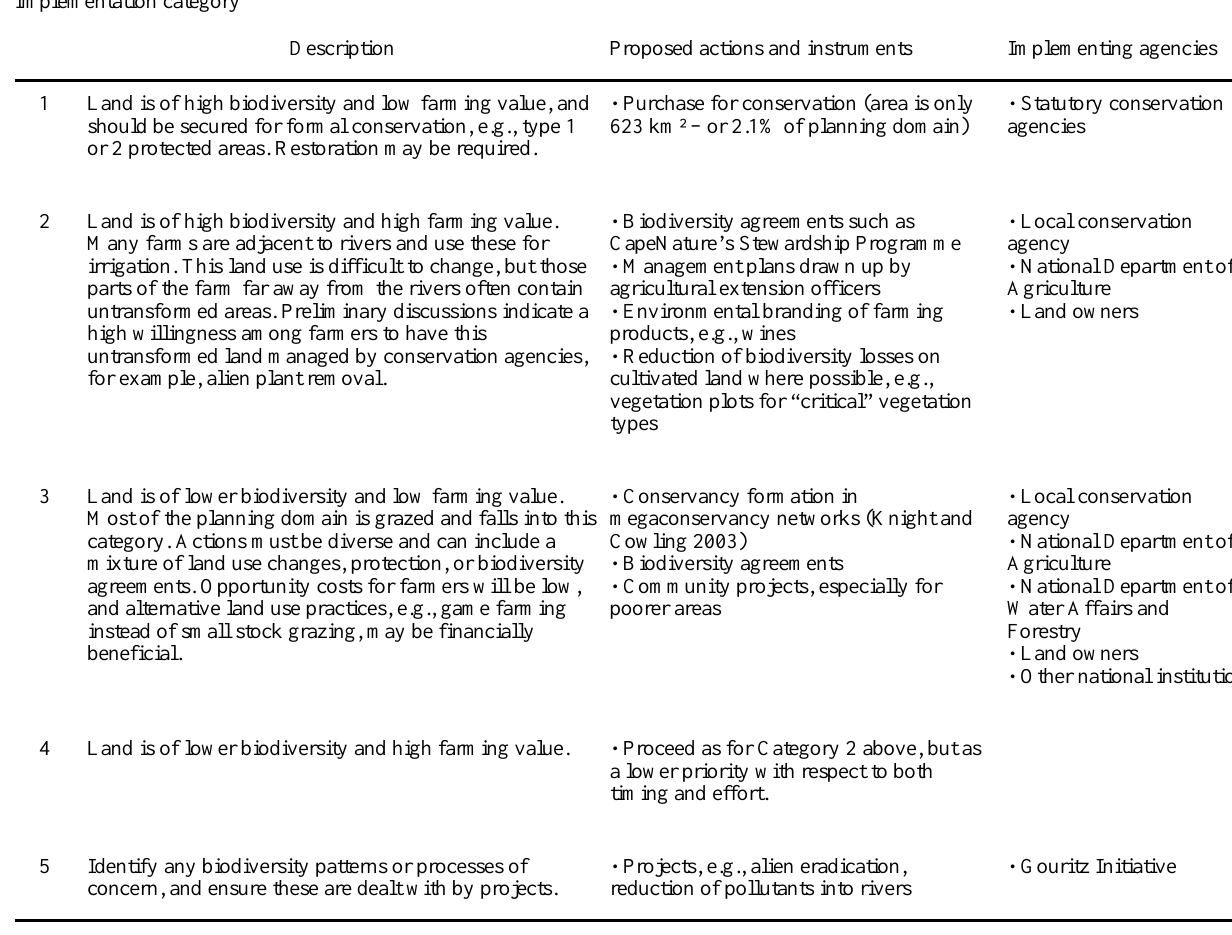
Table 2. Description of the land use types within the five implementation categories defined in Fig. 7, and proposed actions and instruments to achieve conservation outcomes in each of these categories. Implementation category Description Proposed actions and instruments Implementing